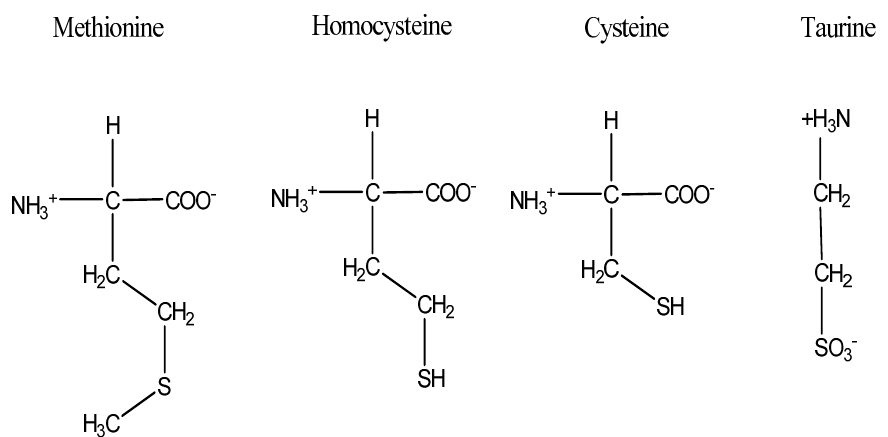
Figure 2. The structures of sulfur containing amino acids: methionine, homocysteine, cysteine and